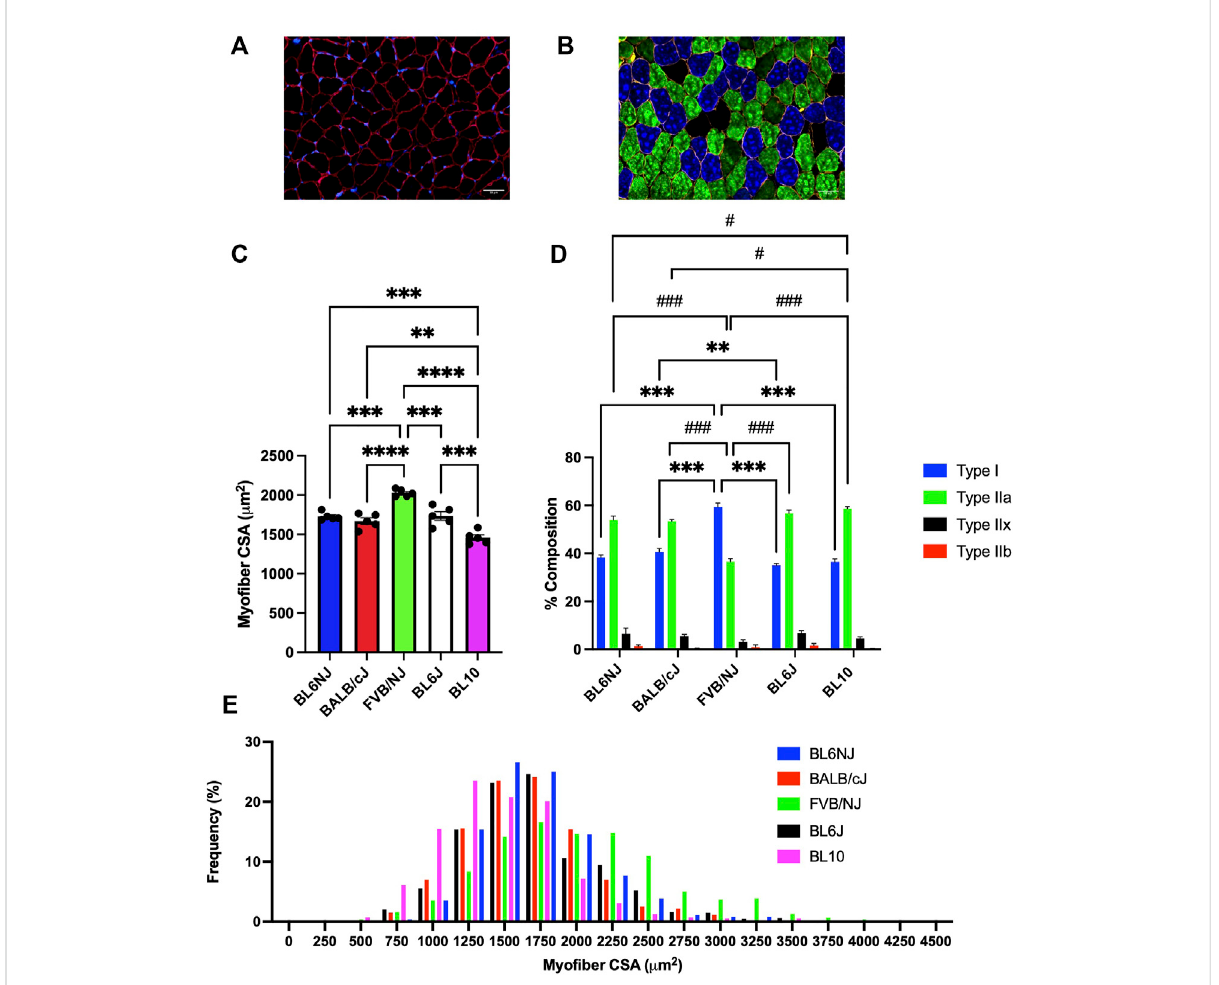
FIGURE 10 Averagemyo fi berCSAand fi bertypecompositionofthesoleusmusclefromvariousstrainsofmice. (A) Representativecross-sectionalimageof a BL6J soleus stained for dystrophin to outline the sarcolemma (red) and nuclei (DAPI, blue); (B) Representative cross-sectional image of a BALB/cJ soleusprobedfordystrophin(yellow) andthefollowingMHCisoforms — TypeI(blue),TypeIIa(green),TypeIIx(black), andType IIb(red); (C) Average CSA of individual fi bers; (D) Average fi ber type distribution of individual muscles; (E) Frequency distribution of all fi bers measured in the soleus muscles from each strain. * = difference in Type I; # = difference in Type IIa. Statistically signi fi cant difference is indicated by one symbol = p < 0.05; two symbols = p < 0.005; three symbols = p <